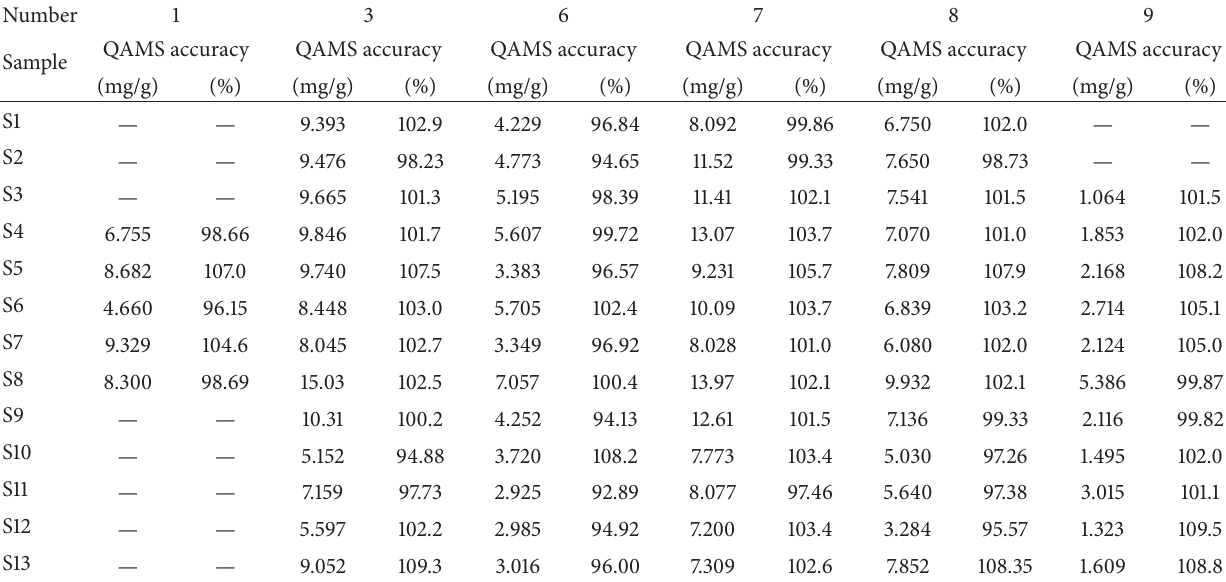
Table 7: Results of QAMS quantitative determination of marker